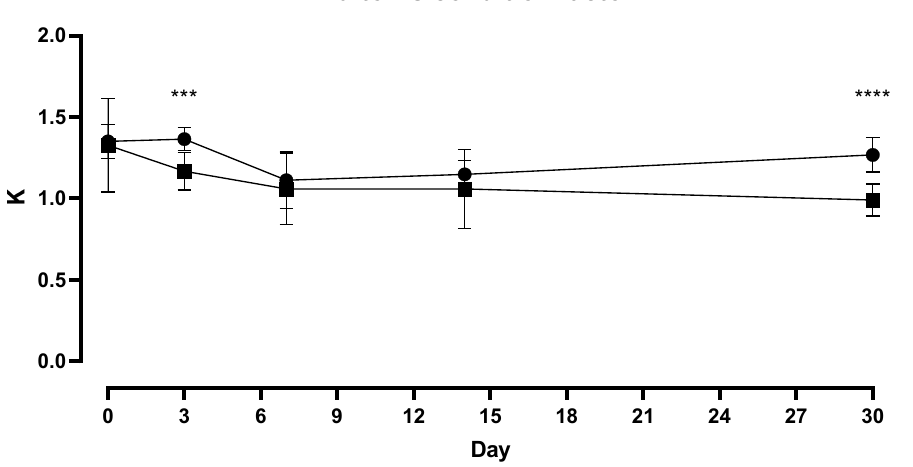
Figure 1. Fulton’s condition factor of trout ( O. mykiss ) exposed to control (natural photoperiod; solid circle) and artificial (LD24:0; solid square) photoperiods. Asterisks (*** and ****) indicate significant differences between treatments (day 3; p = 0.0002 and day 30; p < 0.0001, respectively). Spots represent mean and ± Standard deviation.